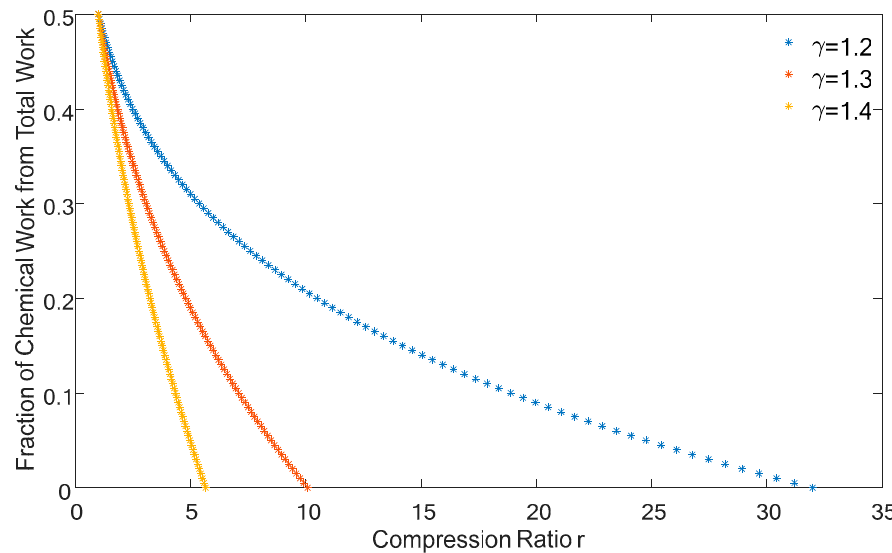
Figure 4. Electro-chemical energy conversion fraction for maximal power as a function of the compression ratio.